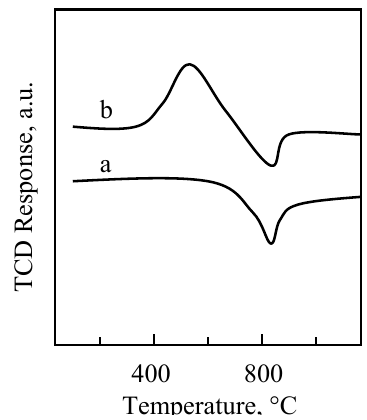
Figure 5 . Spectra for activated carbon support: ( a ) TPD curve in pure Ar; and ( b ) TPR profile in H /Ar gas mixture. 2